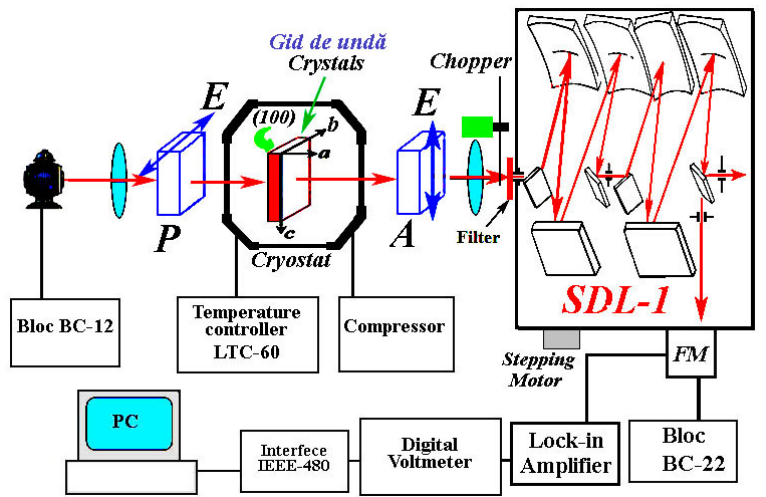
Figure2. Experimental set-up for transmission spectra